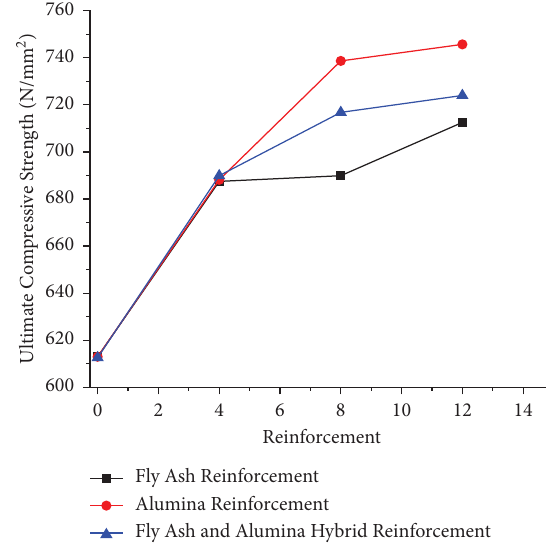
Figure 15: Compressive strength of various composites. Repro- duced with permission from Ref. [92], copyright 2014,